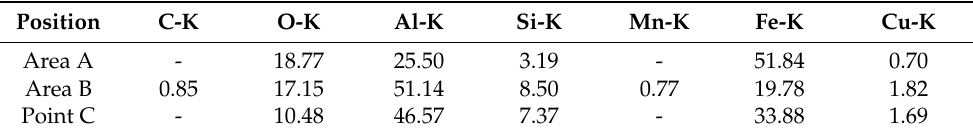
Figure 12. ( a ) Plate ‐ like debris of the SiCp/Al ‐ 5Si ‐ 1Cu ‐ 0.5Mg sample after T6 heat treatment and ( b ) EDS result of point C. Table 4. EDS results of area A, area B and point C (wt